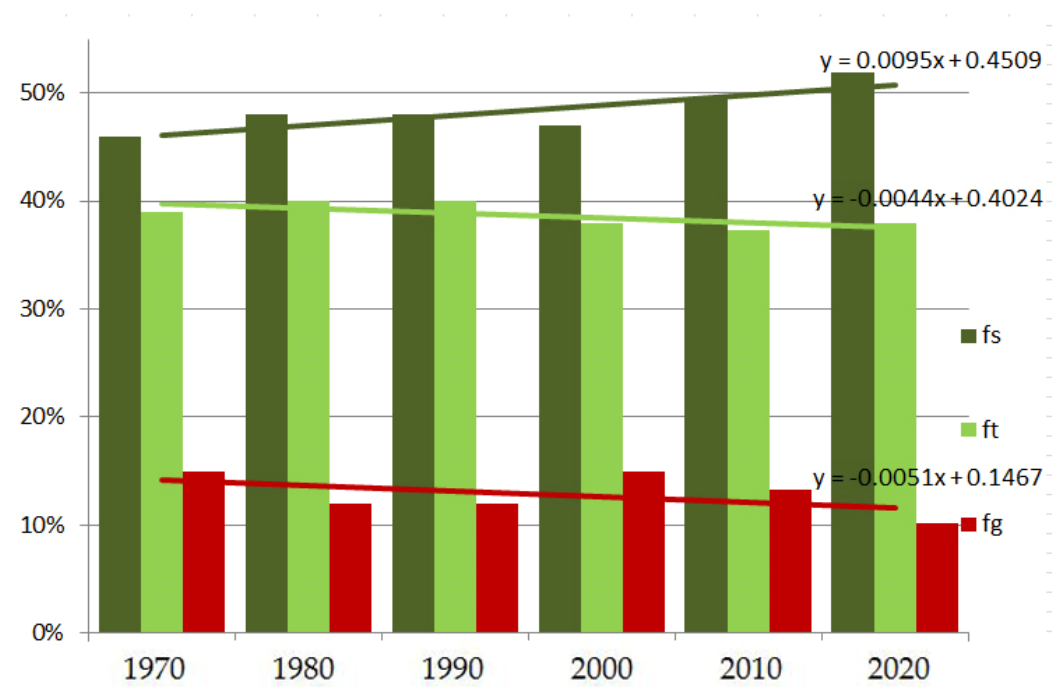
Figure 10. Land-use changes (period 1970–2020): fs, forests ( suma ); ft, grass ( trava ); fg, bare land ( goleti ).